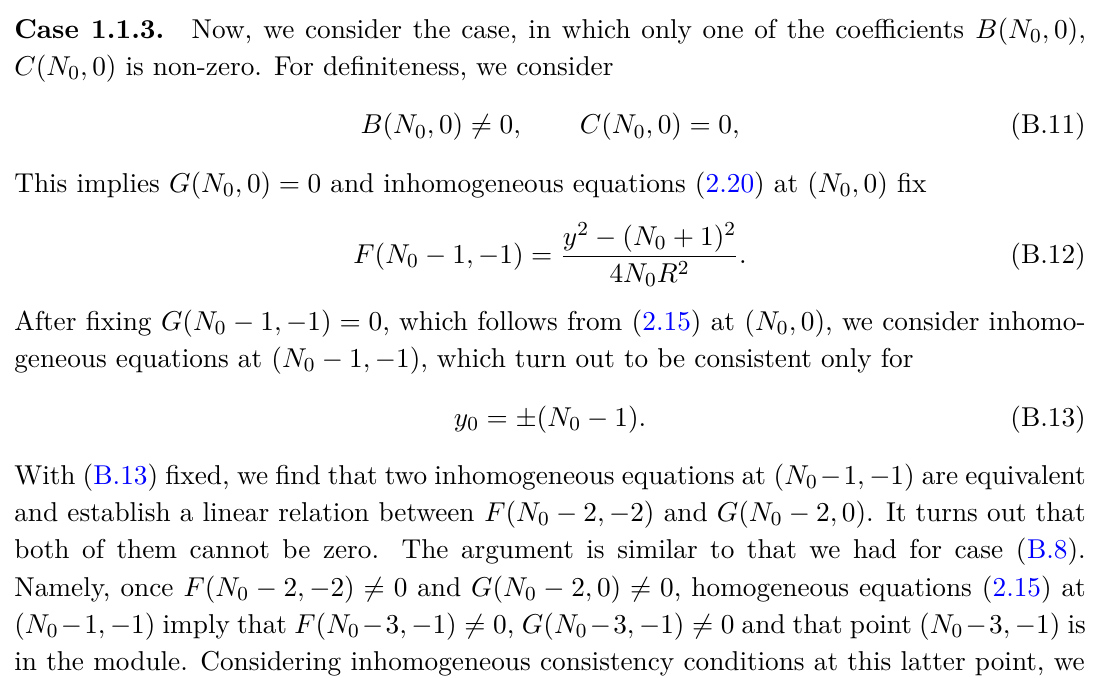
Figure 3 . This figure illustrates the weight space for Case 1.1.1. The non-vanishing coefficients entering the operators of deformed momenta are given by general formulae (2.25), (2.26) with x 0 = y 0 = N 0 + 1